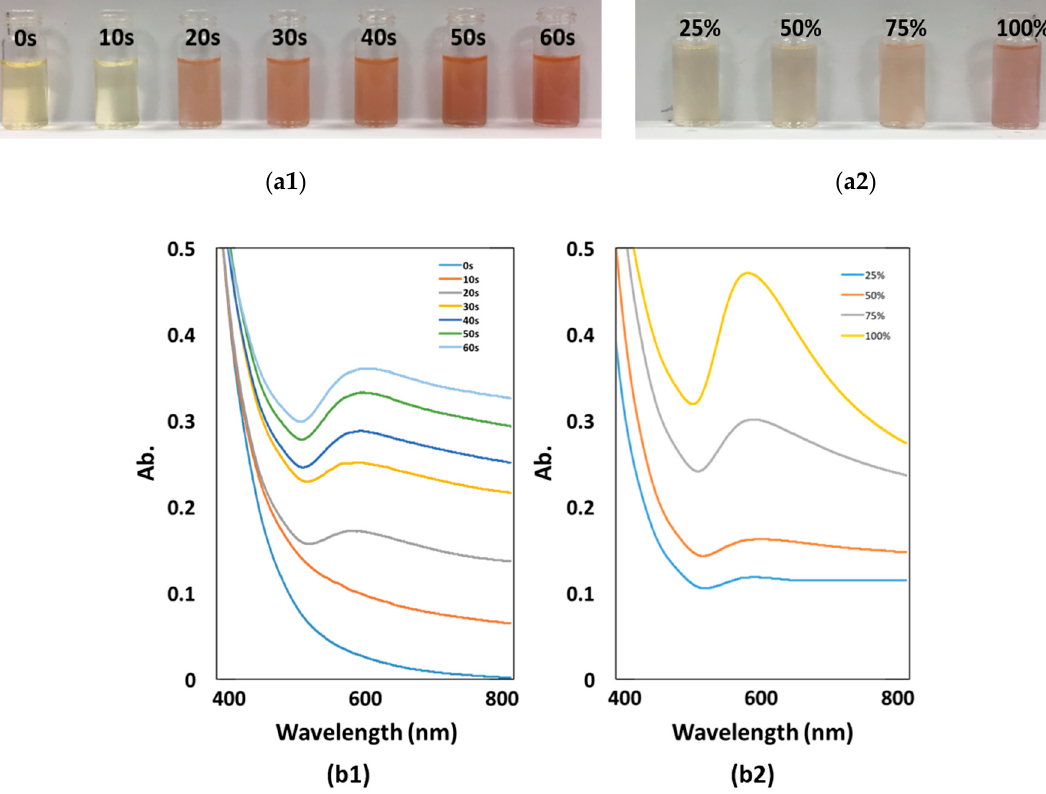
Figure 6. UV-vis spectra of Au NPs synthesized under ( a1 , b1 ) different MV MW irradiation time, ( a2 , b2 ) different MV irradiation power.